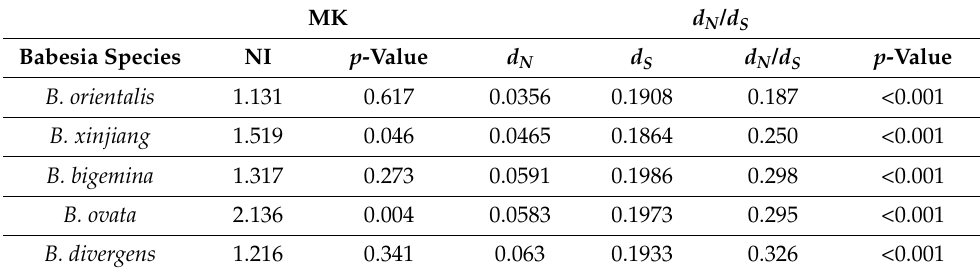
Table 1. Natural selection on ama-1